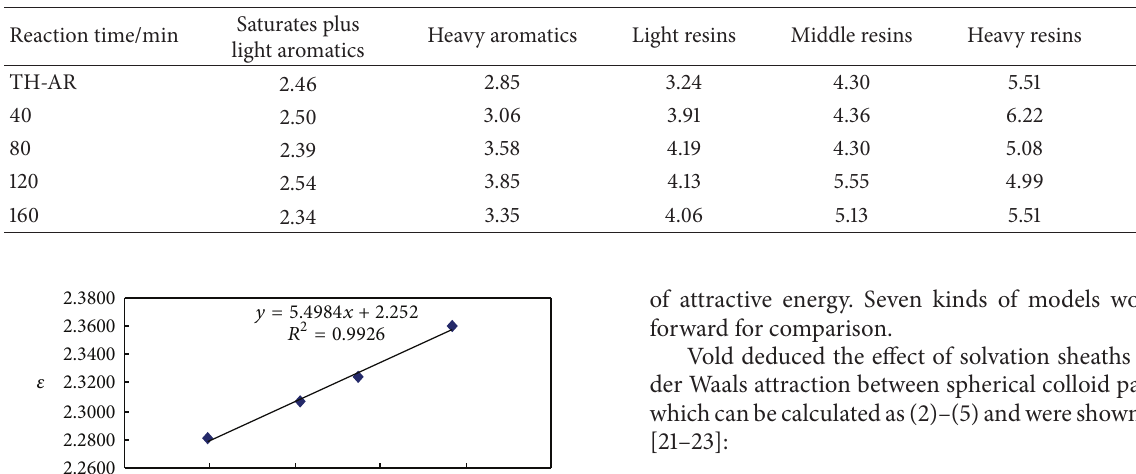
Table 3: Dielectric permittivity of samples of TH-AR thermal reaction at 400 ∘ C.